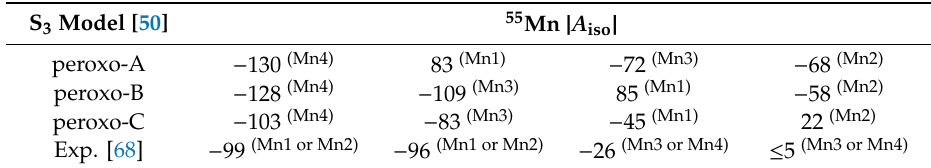
Table 2. Calculated projected 55 Mn isotropic hyperfine coupling constants (MHz) for three peroxo models of the S 3 state discussed by Corry and O’Malley [50], compared to experimental values for the S 3 state ordered from high to low in terms of absolute values. Superscripts in parentheses indicate assignments to individual Mn